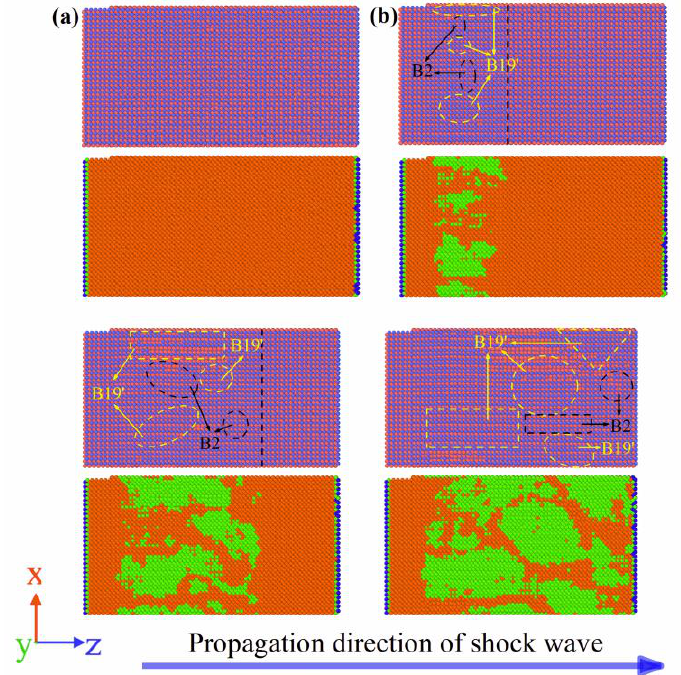
Figure 9. Martensitic transformation at Stage I: ( a ) 0.0 ps; ( b ) 1.0 ps; ( c ) 2.0 ps; ( d ) 3.0 ps. (orange and green represent the B2 phase and B19′ phase, respectively, but blue represents the other phase).